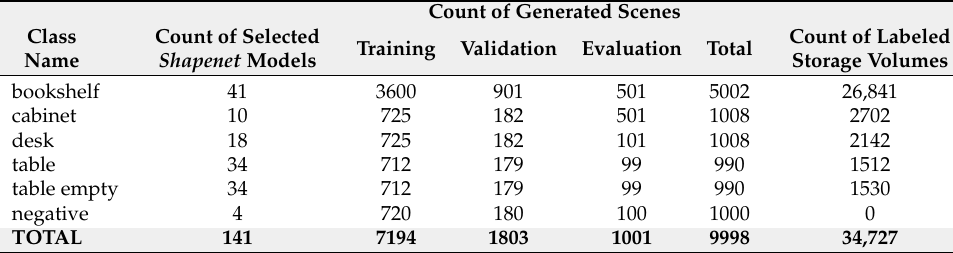
Table 1. Distribution of the generated synthetic dataset per furniture class.